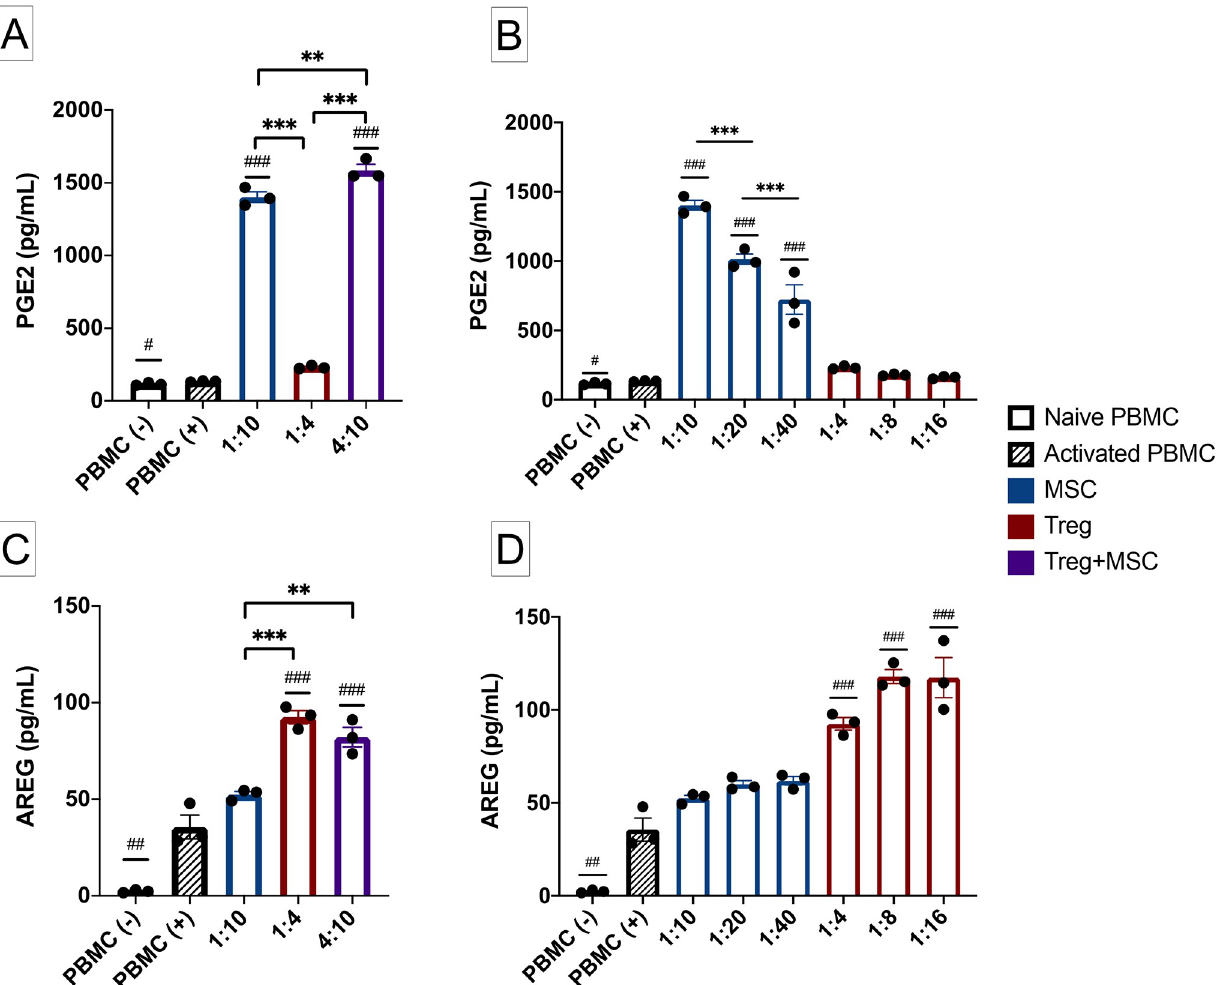
Fig 5. PGE2 and AREG production by Treg, MSC and Treg+MSC in vitro. (A) : PGE2 production by activated human PBMC and MSC, Treg, and Treg +MSC treatments (ELISA). (B) : PGE2 production by activated human PBMC and various ratios of MSC and Treg treatments (ELISA). (C) : AREG production by activated human PBMC and MSC, Treg, and Treg+MSC treatments (ELISA). (D) : AREG production by activated human PBMC and various ratios of MSC and Treg treatments (ELISA). All samples run in triplicate. Statistical significance between naive/treatment and activated control is indicated with (#) for p � 0.05, (##) for p � 0.01, (###) for p � 0.001. Statistical significance between treatment groups is indicated with ( � ) for p � 0.05, ( �� ) for p � 0.01, ( ��� ) for p � 0.001. PGE2, prostaglandin E2; AREG, amphiregulin; PBMC, peripheral blood mononuclear cells; Treg, regulatory T cell; MSC, mesenchymal stromal cell; ELISA, enzyme-linked immunosorbent assay.